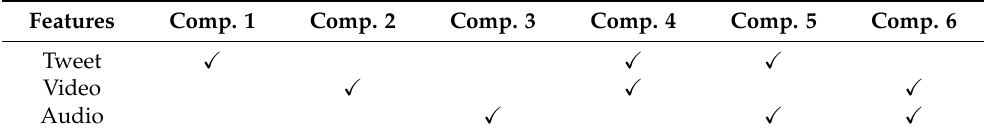
Table 2. Features used in Comps.